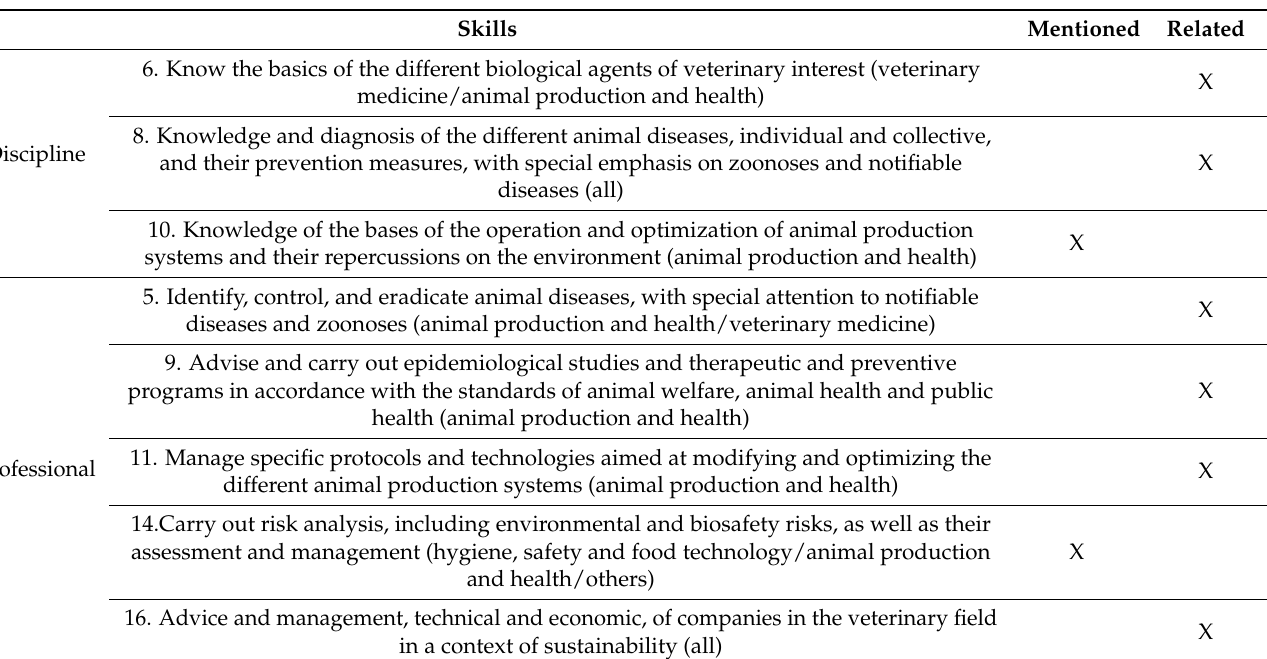
Table 1. Skills described by Spanish Government to develop veterinarian degree and its relation to environmental issues. Skills Mentioned